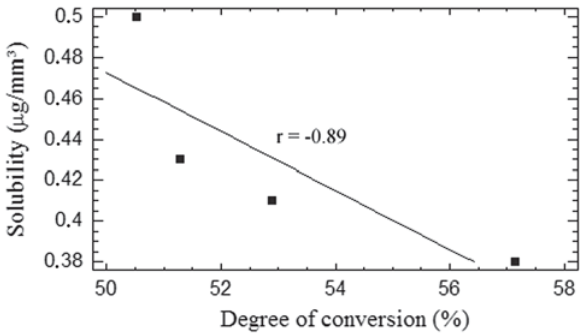
FIGURE 1- Regression line (linear model) of solubility plotted against the degree of conversion (r = -0.89, p <